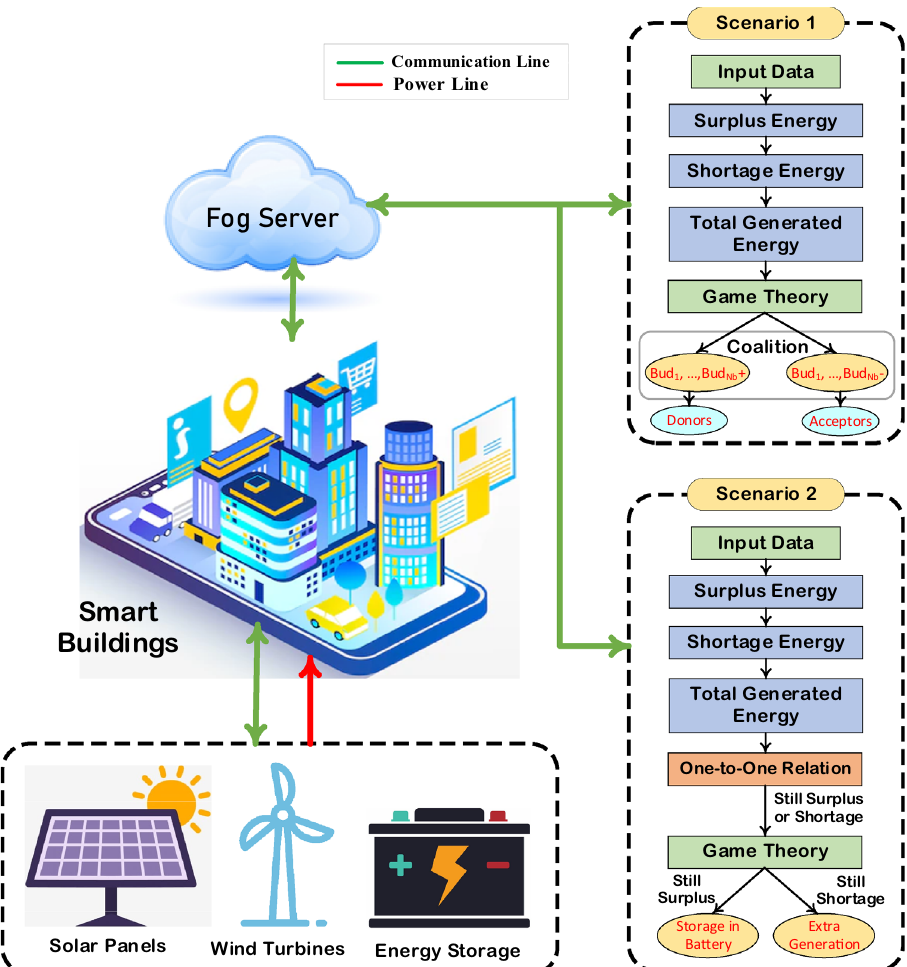
Figure 1. Model of SEM with fog computing and smart metering